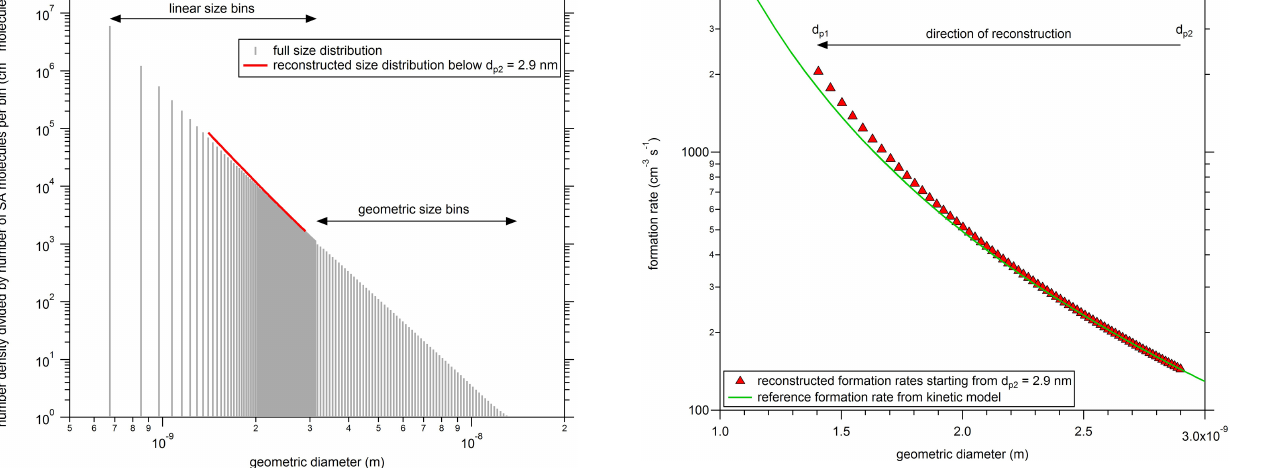
Figure 4. Modeled and reconstructed particle size distribution for kinetic nucleation. The model uses different definitions for the first 100 size bins (up to ∼ 3.1nm) and the last 100 size bins ( > ∼ 3.1nm). In the first 100 size bins, the number of molecules in the particles increases by one between each bin, whereas in the next 100 bins the particle diameter is increased by a constant factor between each bin. Normalizing the concentration by the number of molecules per bin leads to the shown size distribution (grey bars). The reconstructed size distribution using the new method described here is shown by the solid red line, starting from the particle distri- bution above 2.9nm.